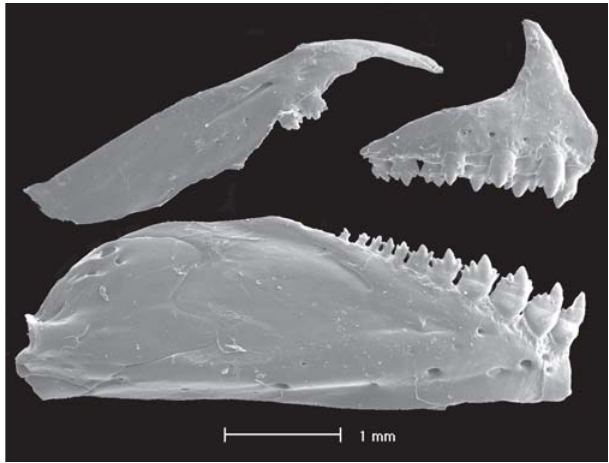
Fig. 5. Astyanax pelecus , MCP 17919, paratype, 51.3 mm SL. SEM image of right side upper and lower jaws